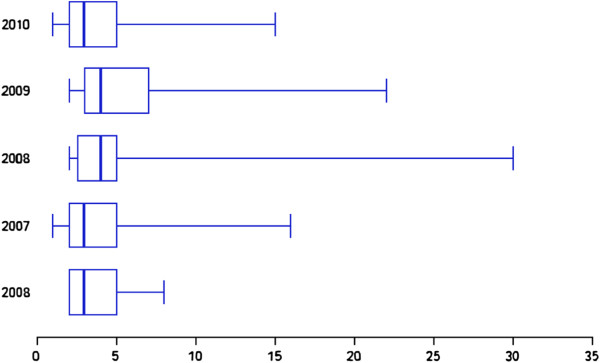
Box plots of postoperative hospital stay (days) over the 5-year study period.